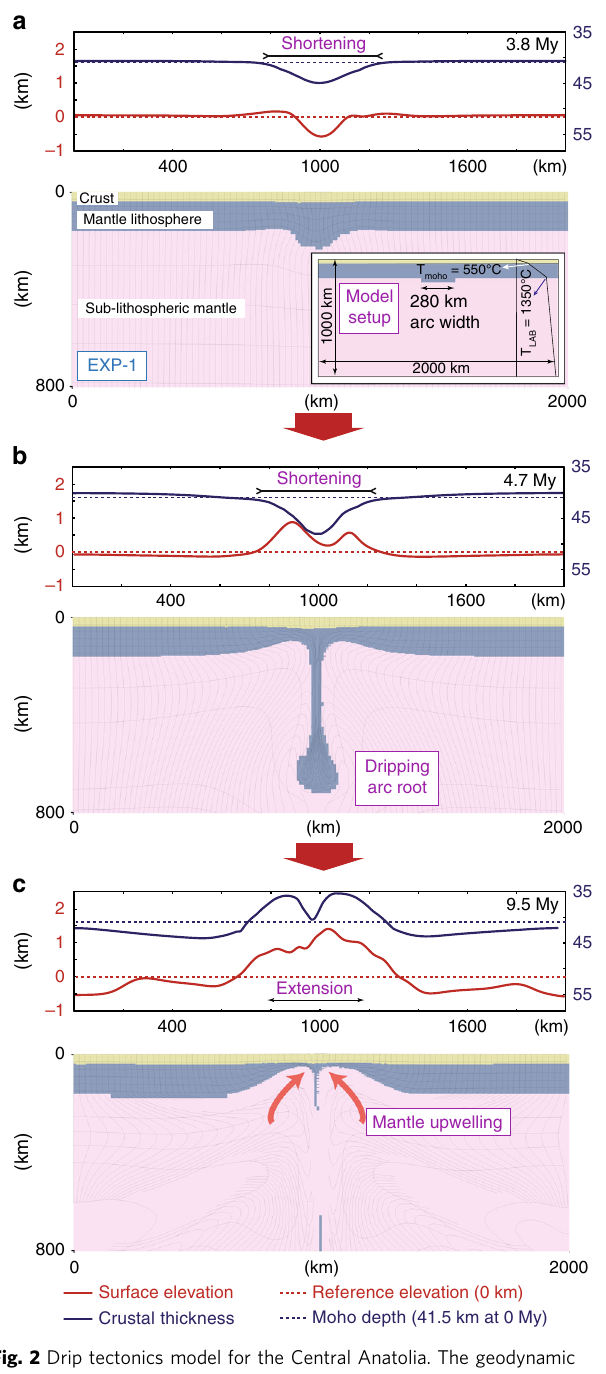
Fig. 2 Drip tectonics model for the Central Anatolia. The geodynamic evolution of EXP-1 (preferred model) for arc root removal and the inset shows the set-up including the arc width, approximately 280 km based on paleomagnetic restorations 31 (see Supplementary Fig. 1 for set-up description). Deforming Lagrangian mesh is overlain on material colors (yellow-crust; blue-mantle lithosphere; pink-sub-lithospheric mantle). At labeled time frames the surface topography and crustal thickness are shown. Note that the relatively minor change from the model symmetry to asymmetry is visible in the surface topography and crustal thickness variations, although not necessarily geologically relevant to Central Anatolia ’ s lithosphere evolution. This is due to the initial model set-up conditions in which the drip initiator at the base of the sub-arc mantle lithosphere (arc root, blue region) is shifted to the left (by several kms) from the